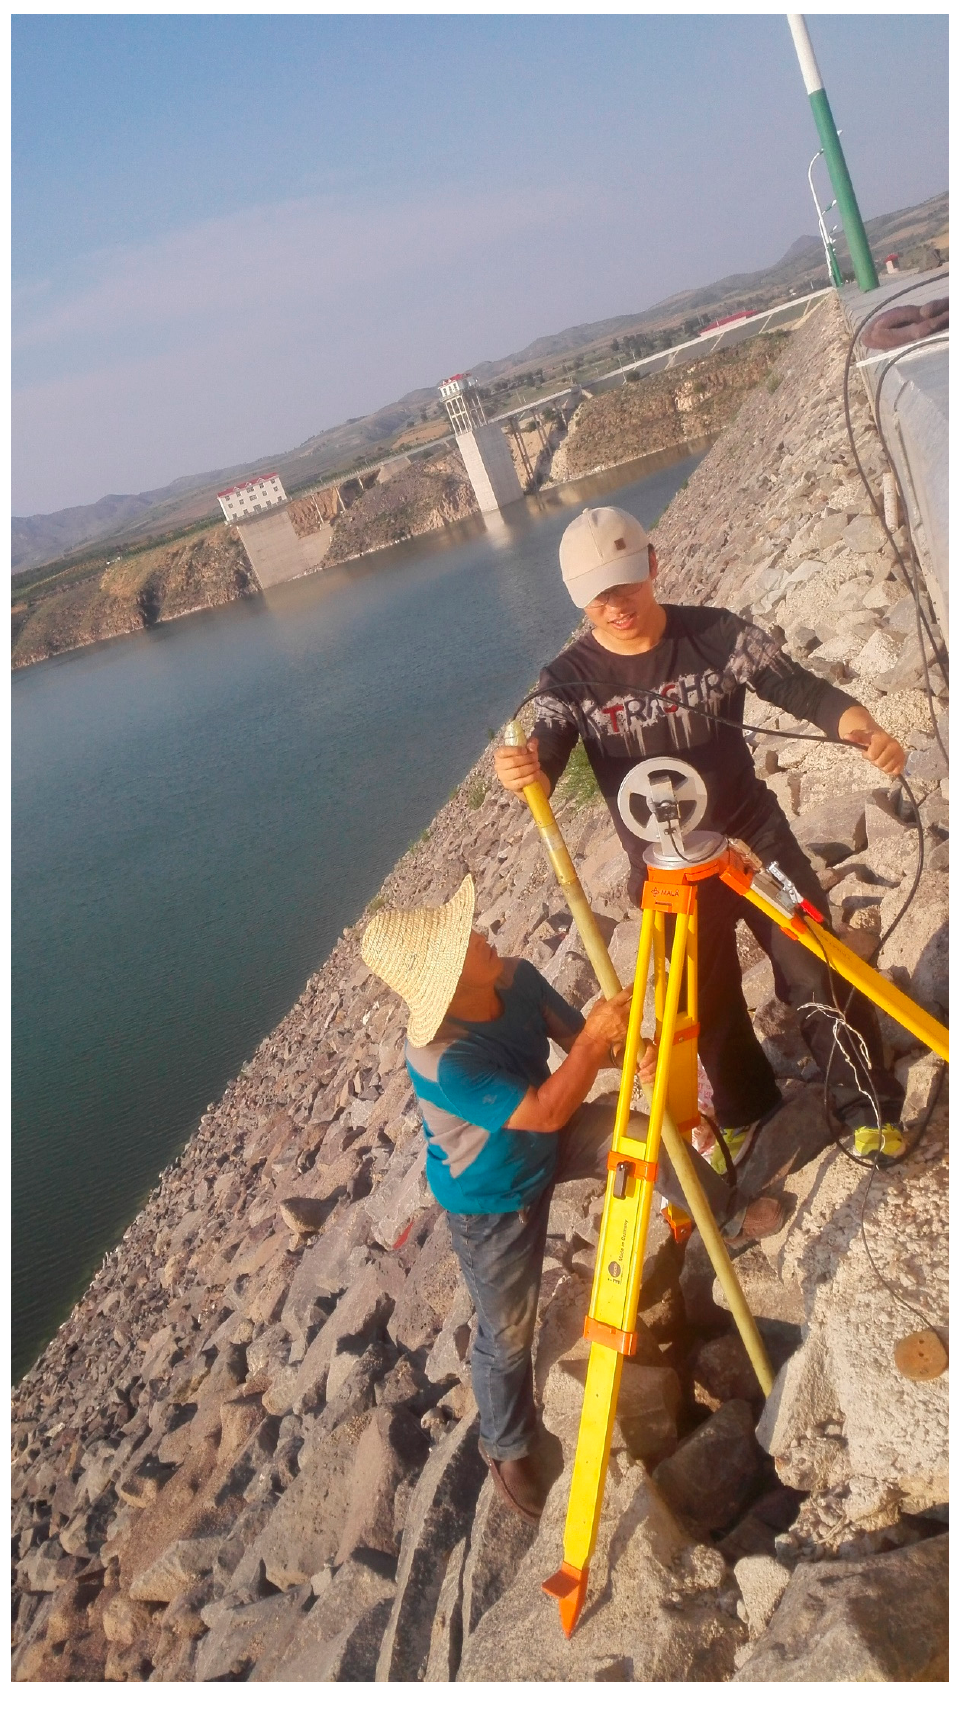
Figure 3. A photo showing the field